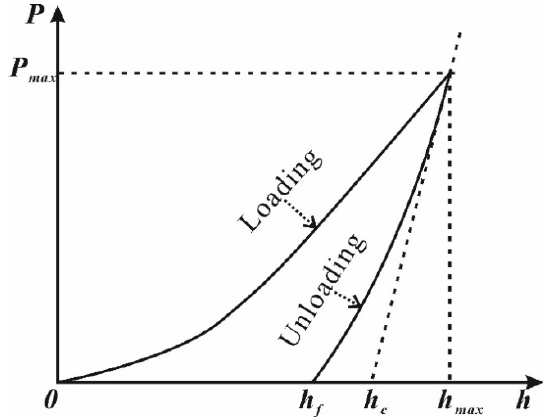
Figure 3. Typical load-displacement curve. h f is the distance between the deepest point of the sunken surface and the initial surface; P max is the maximum loading pressure; h is the depth.